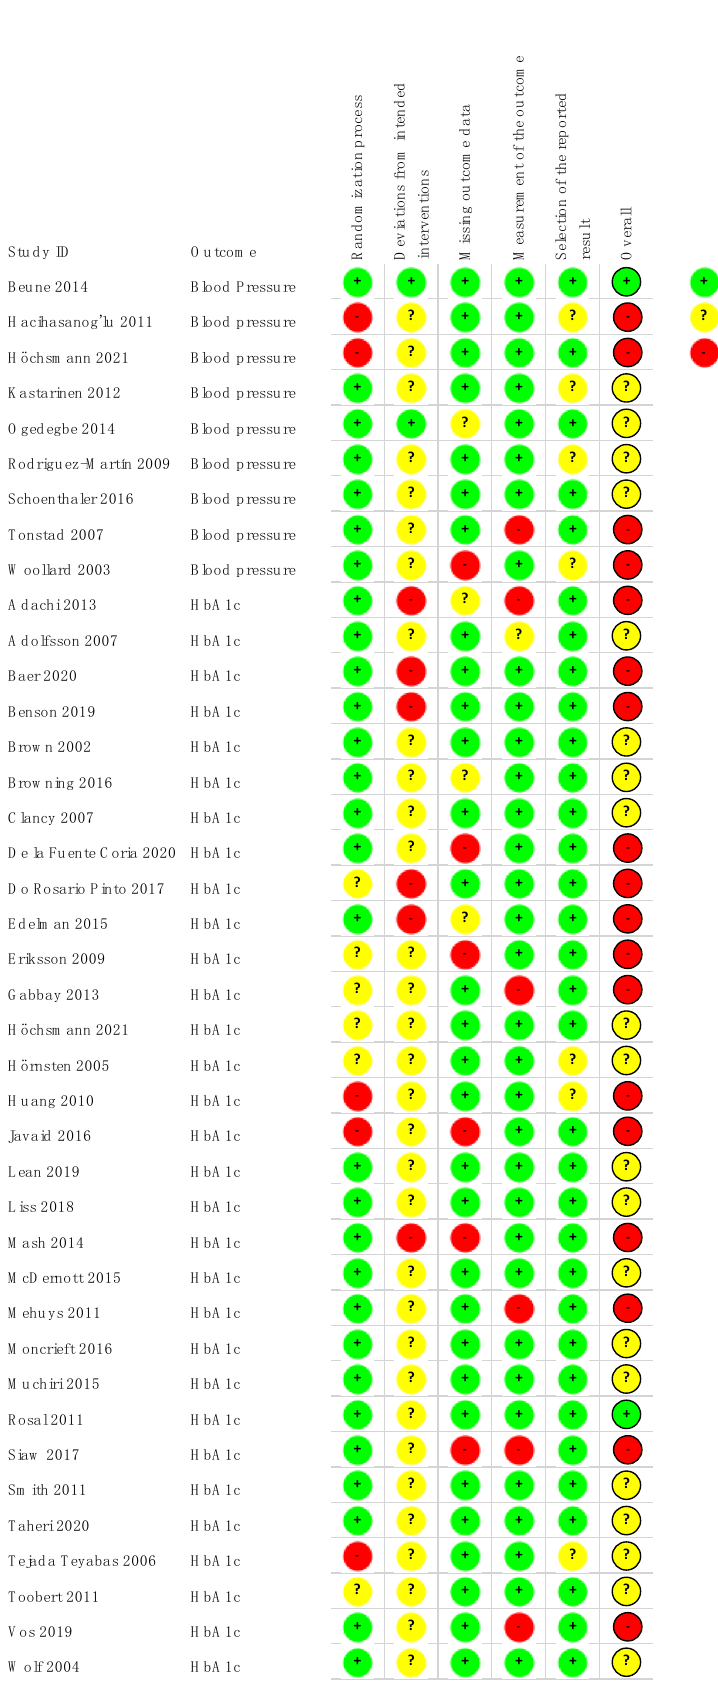
Figure 2. Risk of bias of included studies according to the main outcomes analyzed.